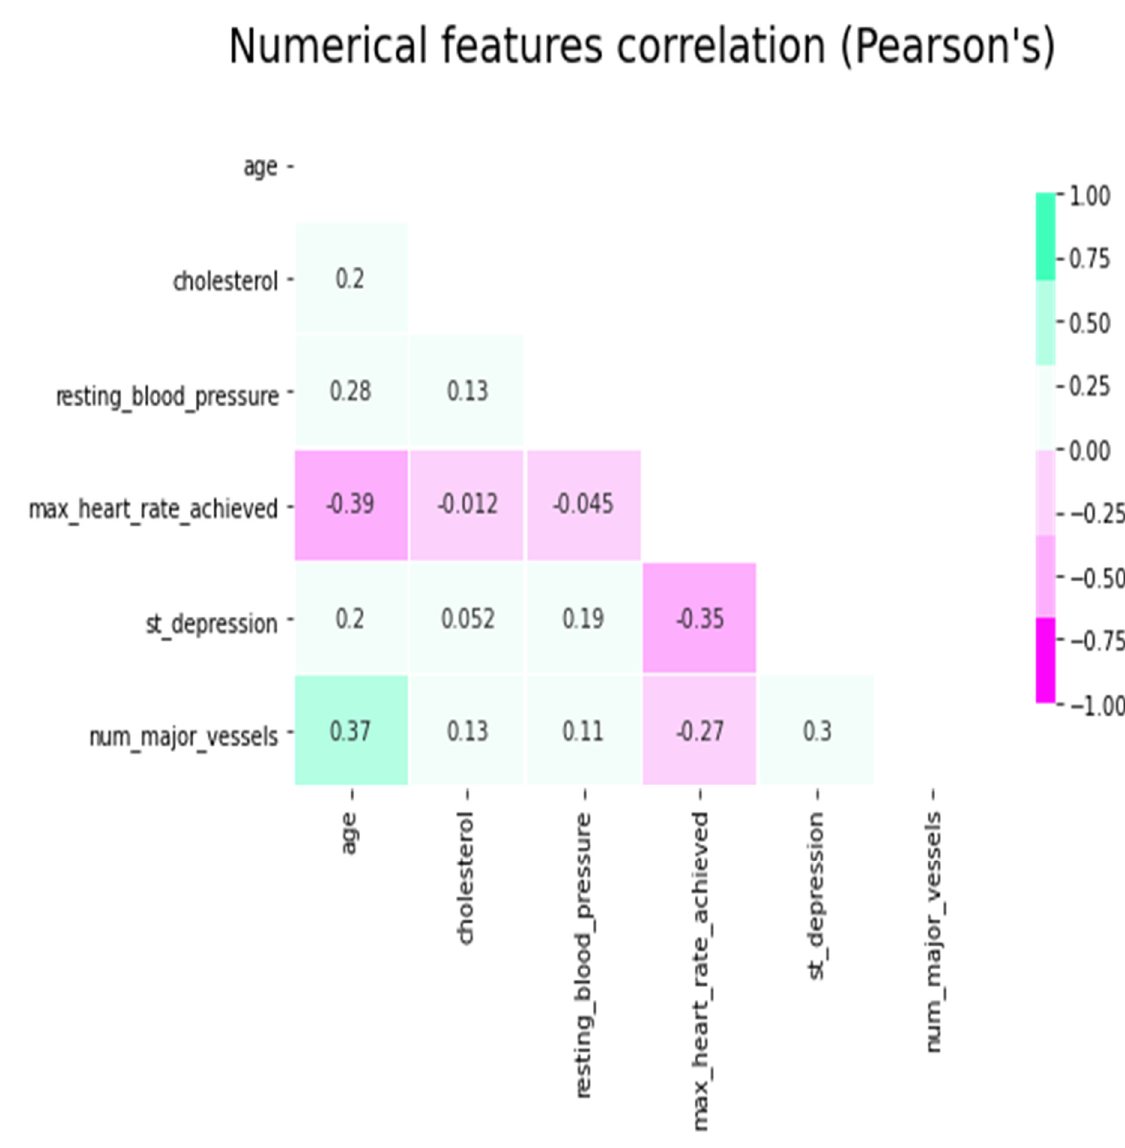
Figure 10. Numerical features correlation (Pearson’s).